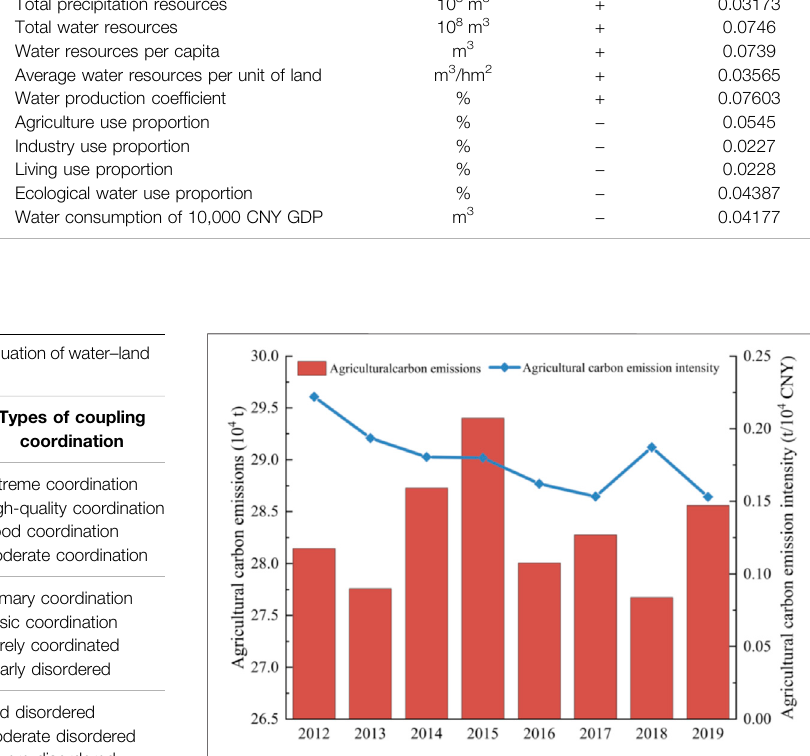
FIGURE 3 | Variations and intensity of agricultural carbon emissions in Zhangye during 2012 –